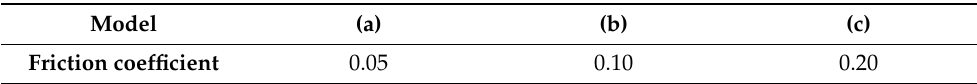
Table 6. Models with different friction coefficients.